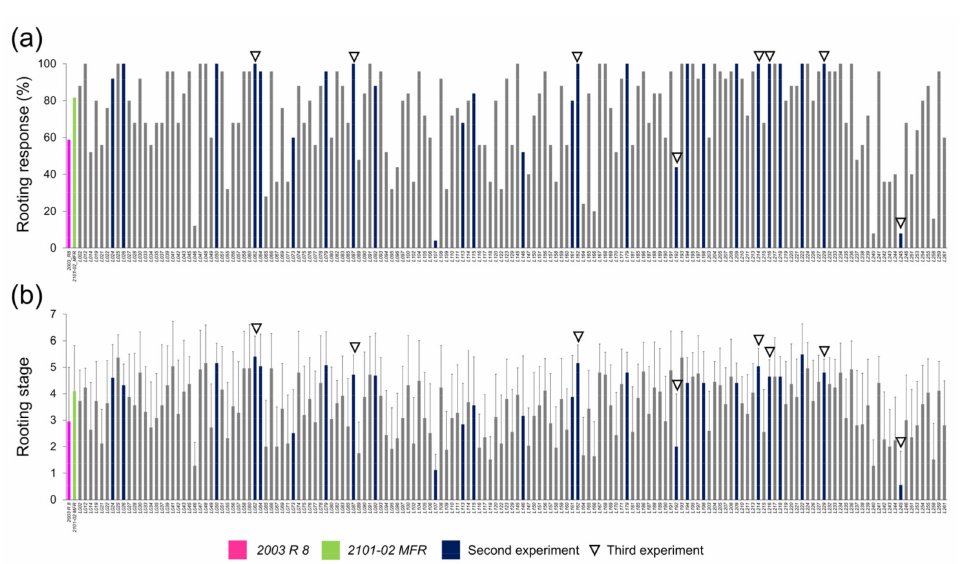
Figure 2. Quantitative description of some rooting parameters of the F 1 lines derived from a cross between 2003 R 8 and 2101-02 MFR . ( a ) Rooting response (%) and ( b ) rooting stage of the studied lines in the first experiment (n = 159) at 20 dap. The blue bars indicate the lines selected for the second experiment (n = 26), and the arrowheads indicate the lines selected for the third experiment (n =